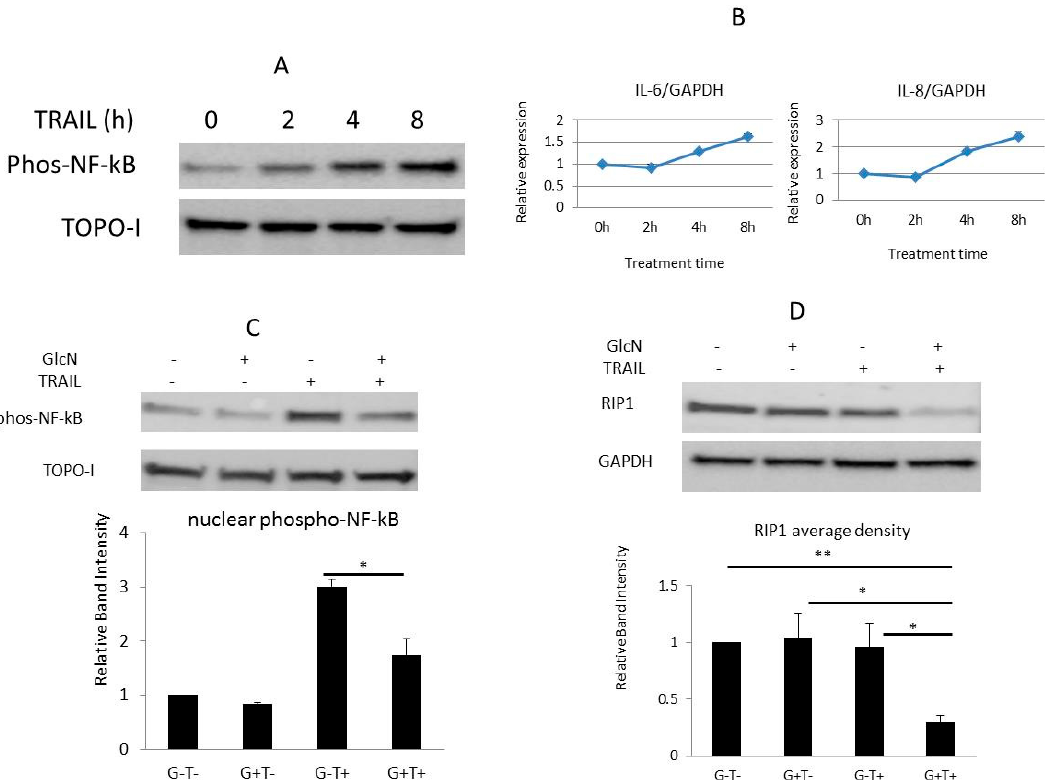
Figure 3. GlcN / TRAIL suppresses TRAIL-activated NF-kB signaling via inhibiting RIP1 and phosphorylation of NF-kB. ( A ) Cells were treated with TRAIL (50 ng / mL) for the designated time and nuclear extracts were prepared and analyzed by immunoblotting using antibodies against phospho-NF-kB and TOPO-1. ( B ) Cells were treated as in A, and total RNA was prepared for qRT-PCR analysis of IL-6 and IL-8 expression. Values represent the mean of two independent assays. ( C ) Cells were treated as in Figure 1C, nuclear extracts were prepared and analyzed by immunoblotting with antibodies against phospho-NF-kB, and TOPO-1. The bottom panel represents densitometric scanning of the results normalized by TOPO-1 levels. Bars represent the mean value of three independent assays, * p < 0.05. ( D ) Cells were treated as in Figure 1C, whole-cell extracts were prepared and analyzed by immunoblotting by using antibodies against RIP1 and GAPDH. The bottom panel represents densitometric scanning of the results normalized by GAPDH levels. Bars represent the mean value of three independent assays. * p < 0.05; ** p < 0.01.